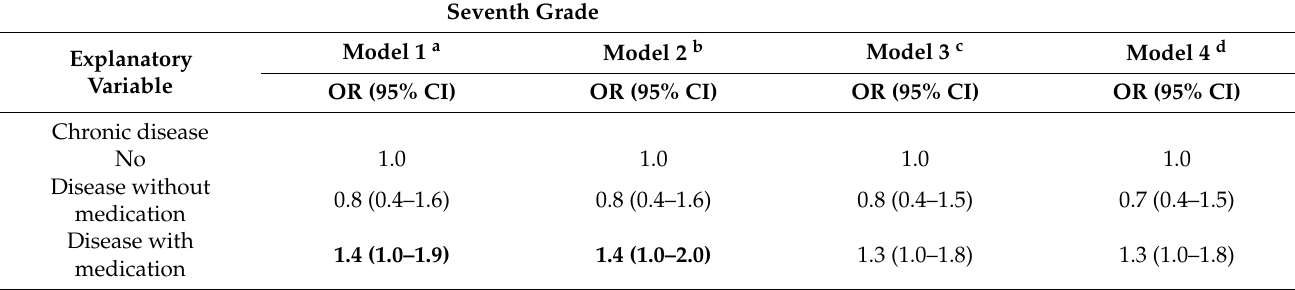
Table 4. The association of chronic disease in the seventh grade ( N = 8938) with the delayed start of upper-secondary school. Bivariate (Model 1) and adjusted logistic regression models (Model 2–4). Odds ratios (OR) and their 95% confidence